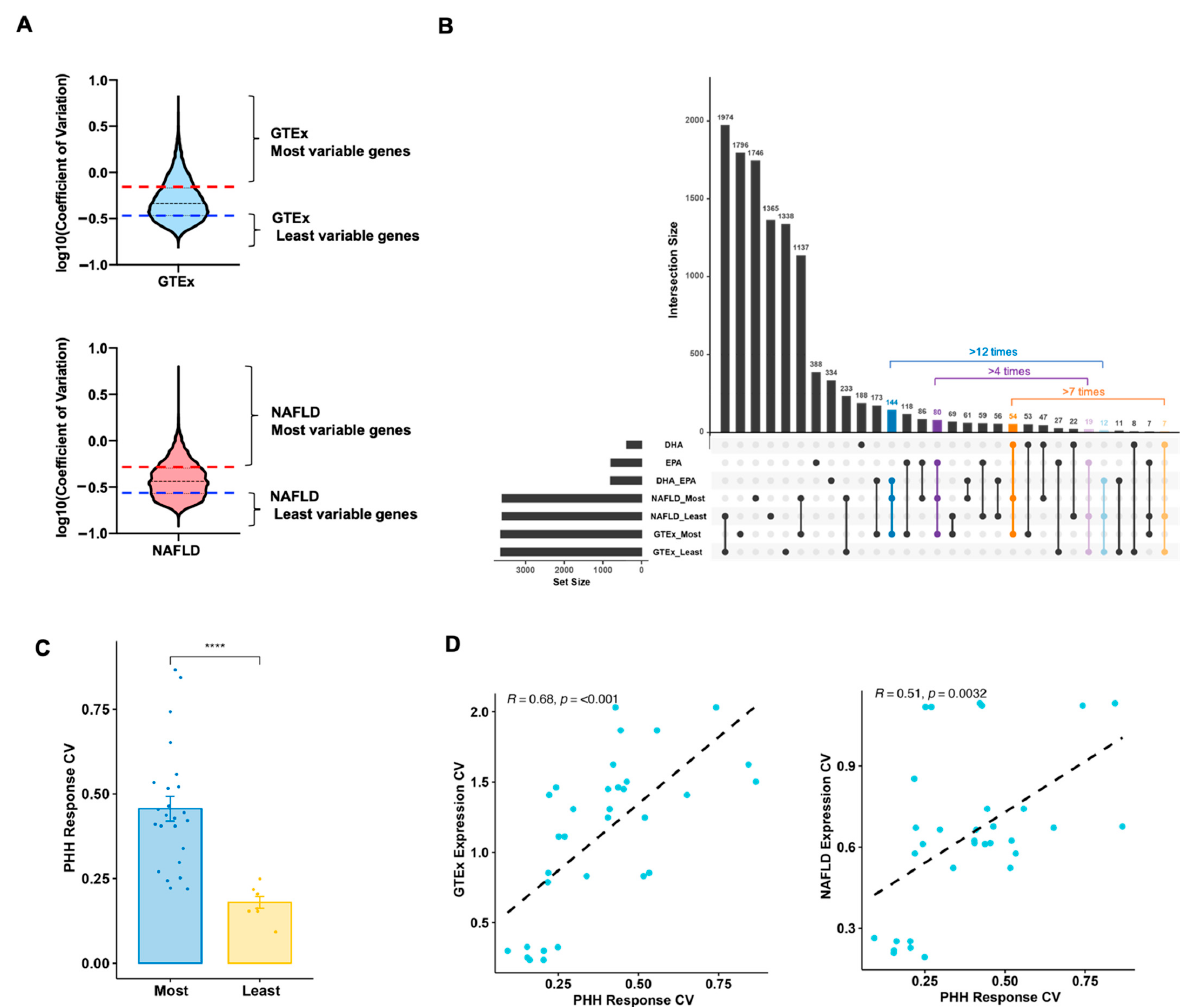
Figure 4. Selection of biomarker genes contributing to individual variation in hepatic response to DHA/EPA. ( A ) Defining genes with most or least expression variability in general (GTEx) or relevant disease (NAFLD) populations. ( B ) Selection of signature genes displaying high population expression variability in general (GTEx) and relevant metabolic disease (NAFLD) populations, while signature genes with least population expression variability in human populations served as negative controls. Here, the UpSet plot summarized the intersections of each group of signature genes and the most or least variable hepatic genes in general/relevant disease populations. ( C ) Response coefficient of variation (CV) for signature genes with high expression variability was significantly higher than those exhibiting low expression variability in human populations. Coefficient of variation was calculated to represent the response variability based on their responses across a panel of 10 donors. **** p < 0.001, two-tailed unpaired Student’s t-test was performed to compare most variable versus least variable signature genes. ( D ) Correlation of coefficient of variation between the expression in general/relevant disease populations and responses in PHH (Primary human hepatocytes) were